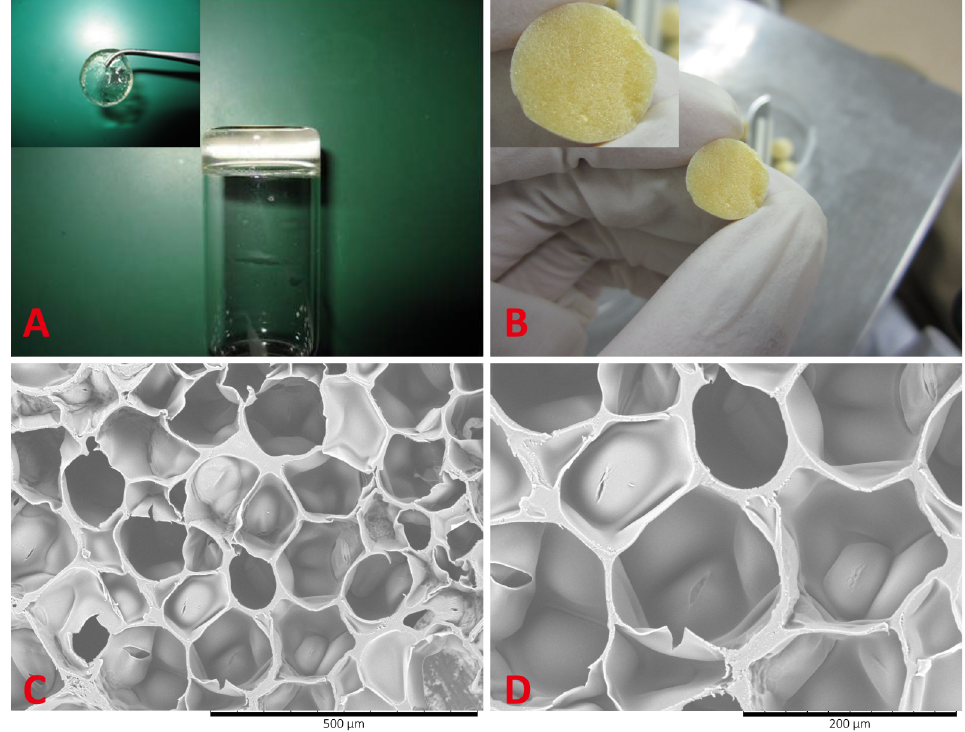
Figure 4. Morphology of the dextran/gelatin hydrogels. A: Gross view of the dextran/gelatin hydrogel; B: Gross view of lyophilized dextran/gelatin hydrogel; C: SEM micrograph of lyophilized dextran/gelatin hydrogel. Scale bar represents 500 m m. D: SEM micrograph of lyophilized dextran/gelatin hydrogel. Scale bar represents 200 m m.